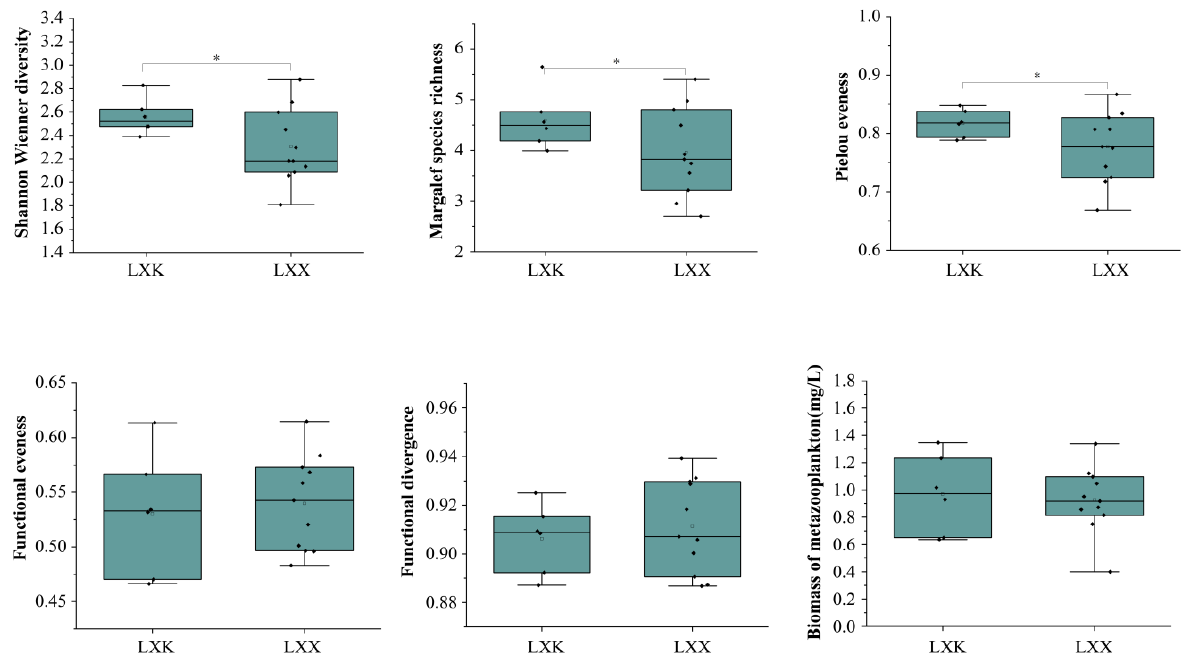
Figure 2. Variations in species diversity and functional diversity (FDiv, FEve) of metazooplankton during cyanobacterial bloom period and non-bloom period. * p < 0.05.